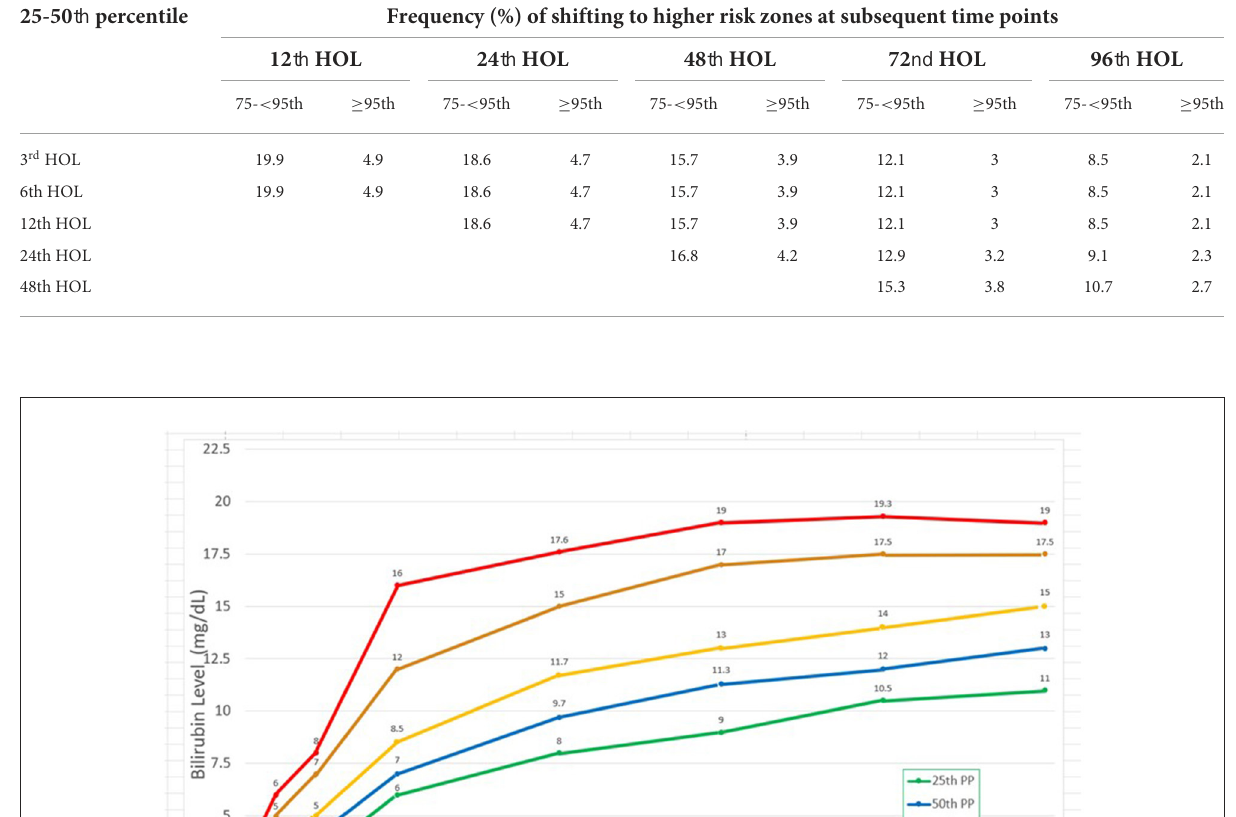
72nd to the 120th HOL but the values did not reach 17 mg/dl (significant